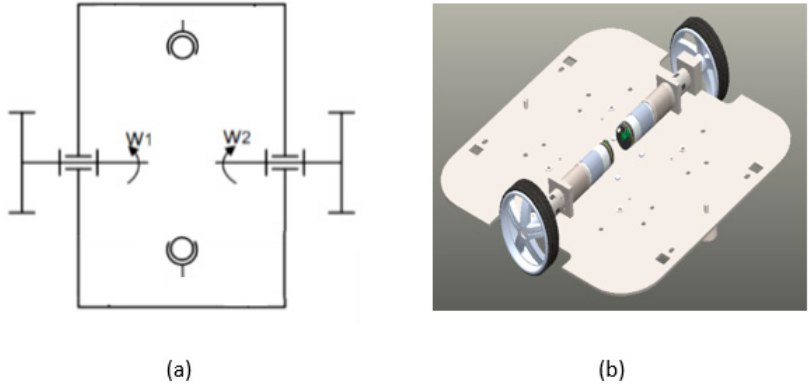
Figure 3. Driving mechanism on bottom layer: ( a ) theoretical design, and ( b ) 3D model.